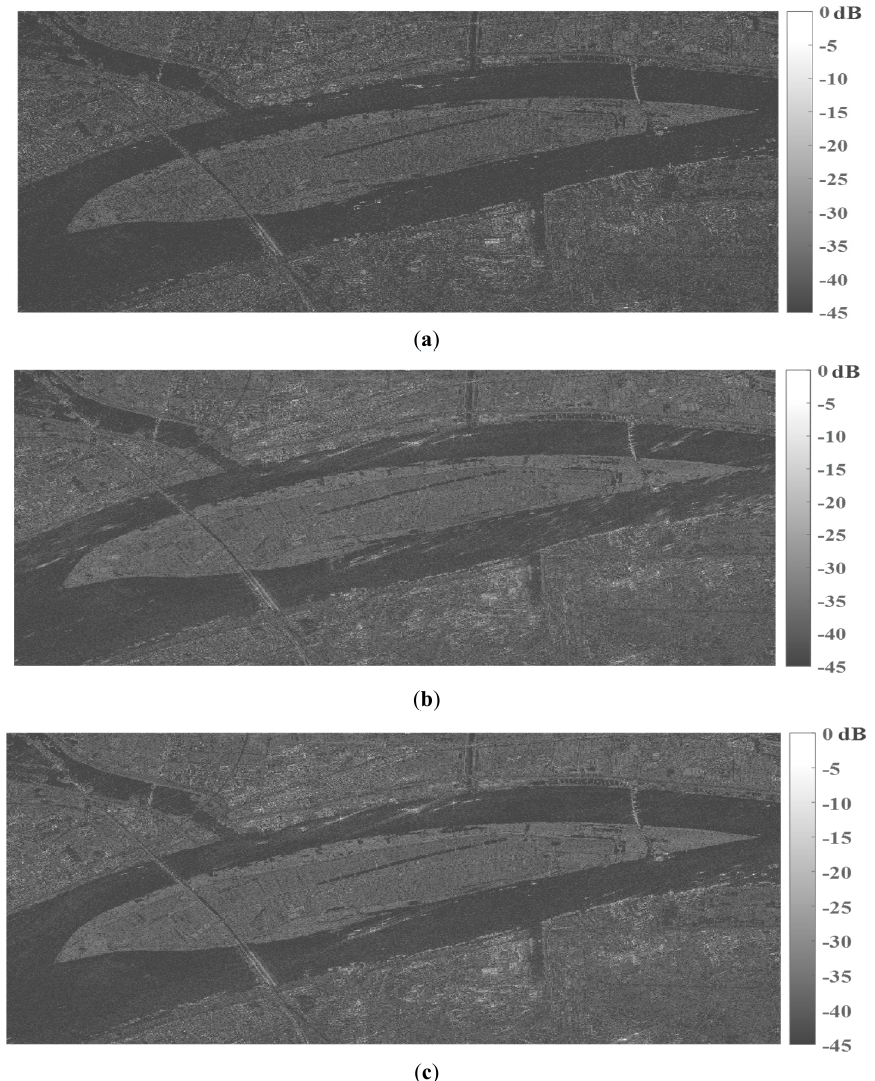
Figure 18. Distributed target simulation experiments of the focused GF-3 SLC SAR image. ( a ) Focused SAR image for simulation; ( b ) imaging result handled by the conventional reconstruction approach based on CHRE; ( c ) imaging result handled by the proposed approach based on AHRE.